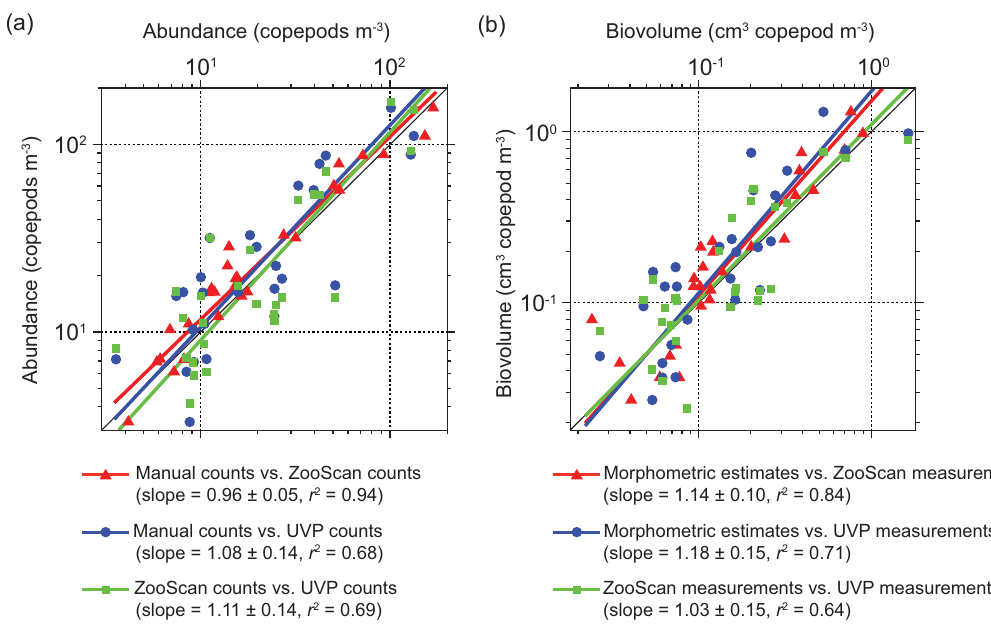
Fig. 10. Linear regressions of the log-transformed mean abundance (a) and biovolume (b) of the total copepod assemblage within the size range of 1–6mm (equivalent spherical diameter) as estimated with traditional zooplankton net tows (further divided into manual and ZooScan estimates) and the Underwater Vision Profiler deployed at each of the overlapping stations (Fig. 1, Appendix A). Each regression presents the fit of one method ( y -axis) versus a second one ( x -axis), but no particular method was considered as the “truth” and the discussion (Sect. 4.2) is aligned on a comparison between